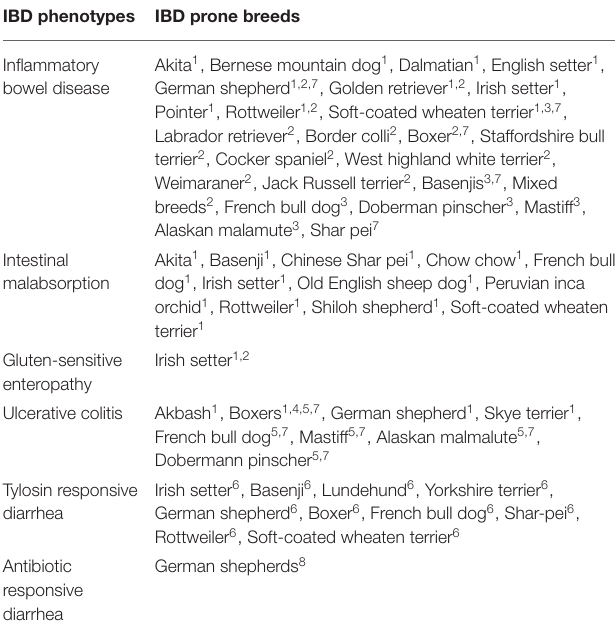
TABLE 1 | Inflammatory bowel disease prone breeds. IBD phenotypes IBD prone breeds Inflammatory bowel